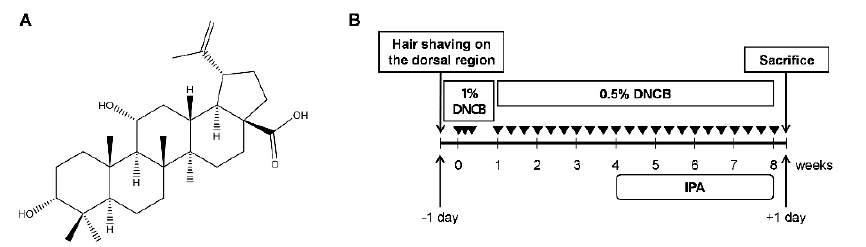
Figure 1. Schematic diagram of 2,4-dinitrochlorobenzene (DNCB)-induced atopic dermatitis (AD)- like skin lesions in BALB/C mice. ( A ) Chemical structure of impressic acid (IPA). ( B ) Schematic representation of the animal experiment.